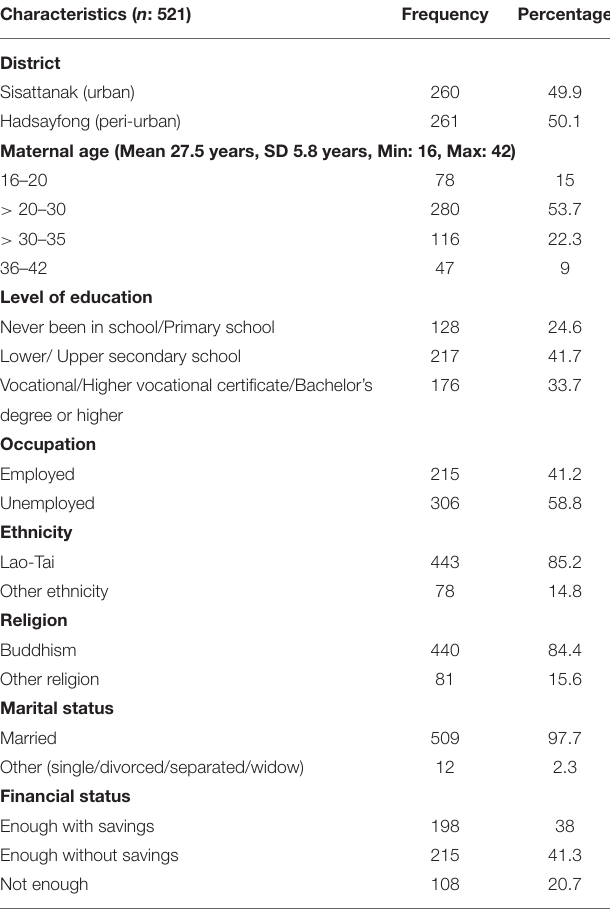
TABLE 1 | Socio-demographic-economic profiles of the participants.